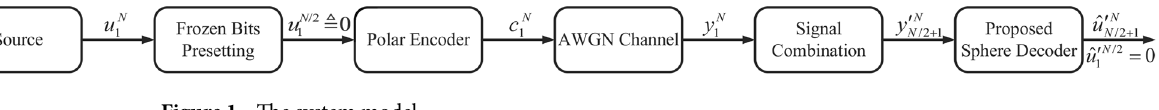
Figure 1. The system